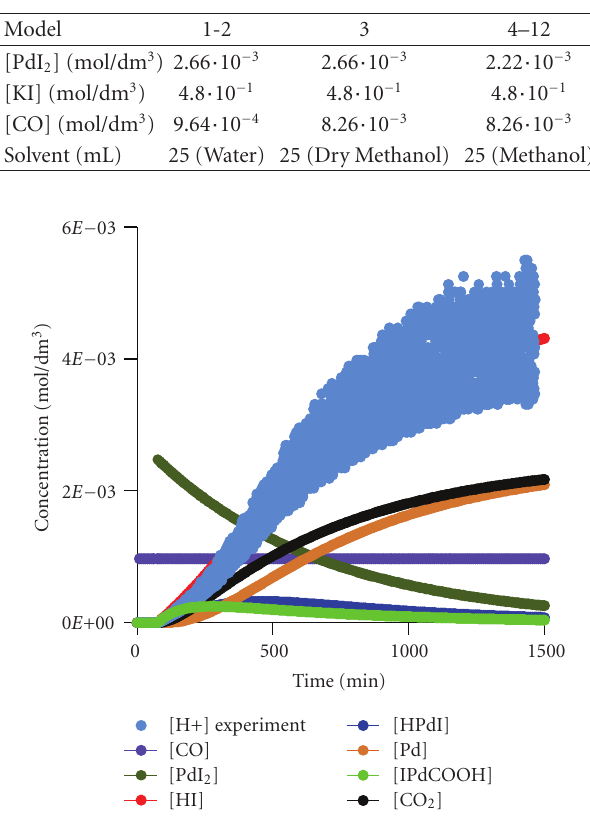
Figure 7: Fitted data using Model 2 against experimental data presented in Figure 2.